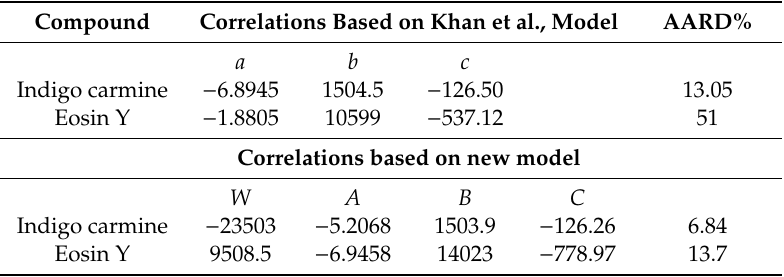
Table 1. Summary of model correlations along with AARD%. Compound Correlations Based on Khan et al., Model